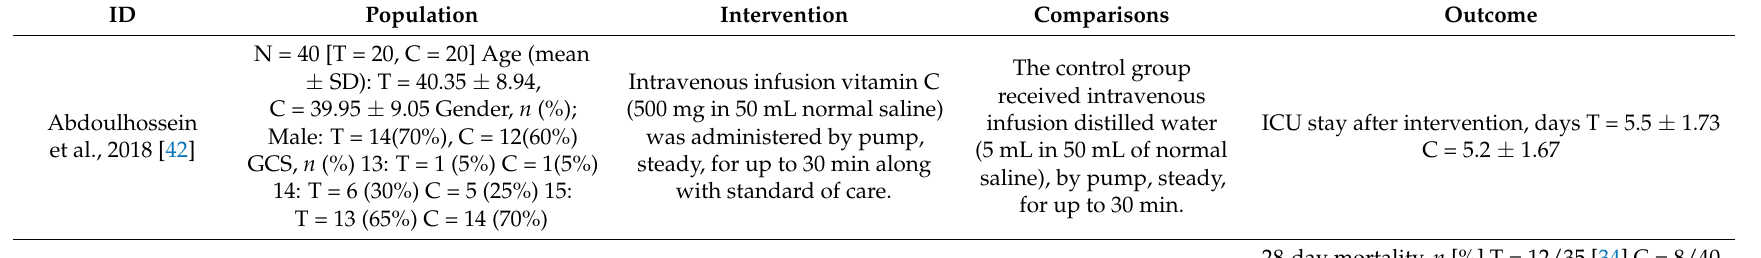
Table 2. Narrative summary of included